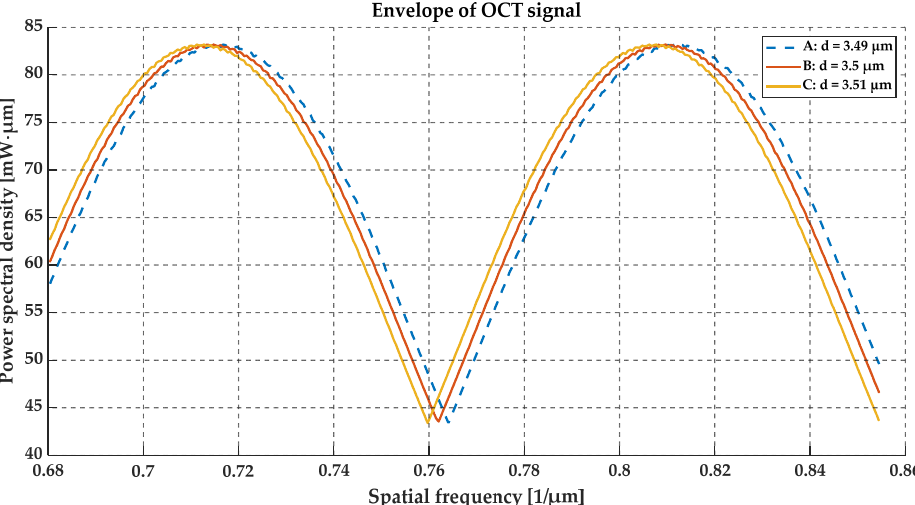
Figure 10. The envelope of the output OCT signal for the glass foils. The difference in the film thickness causes a noticeable shift in the position of the minimum value of the interference contrast.